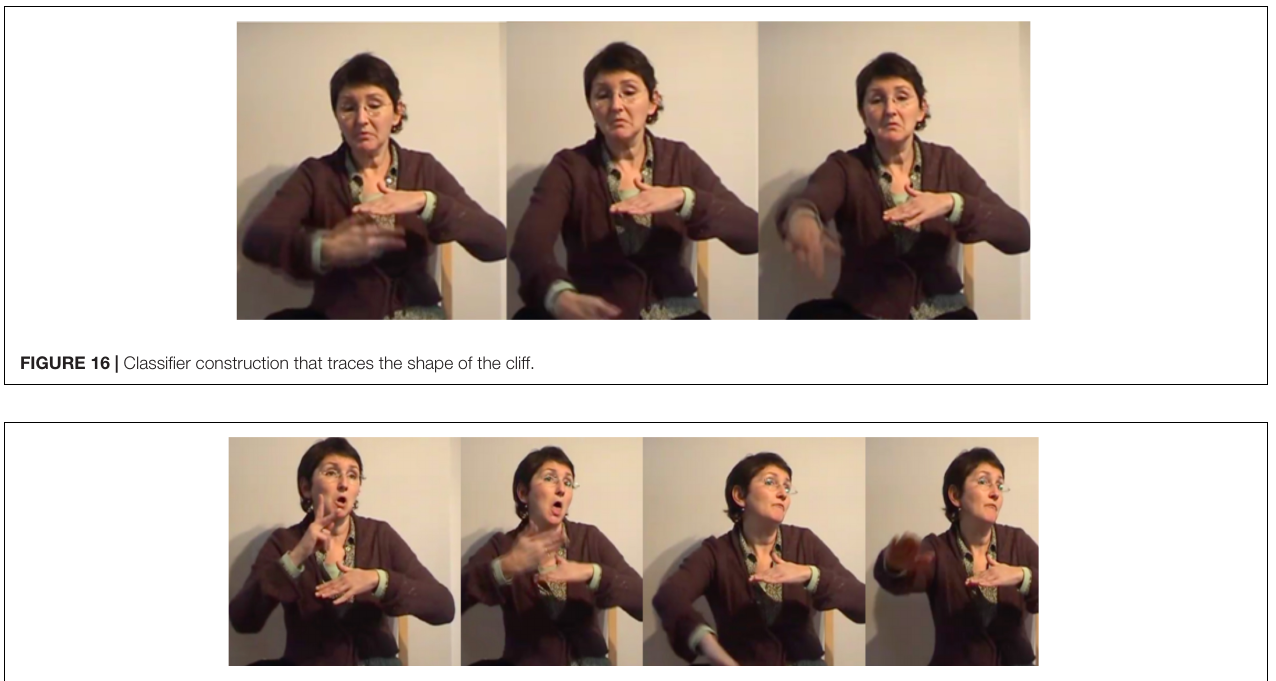
FIGURE 17 | Fingerspelling “K” and repetition of classifier construction that traces the shape of the cliff.